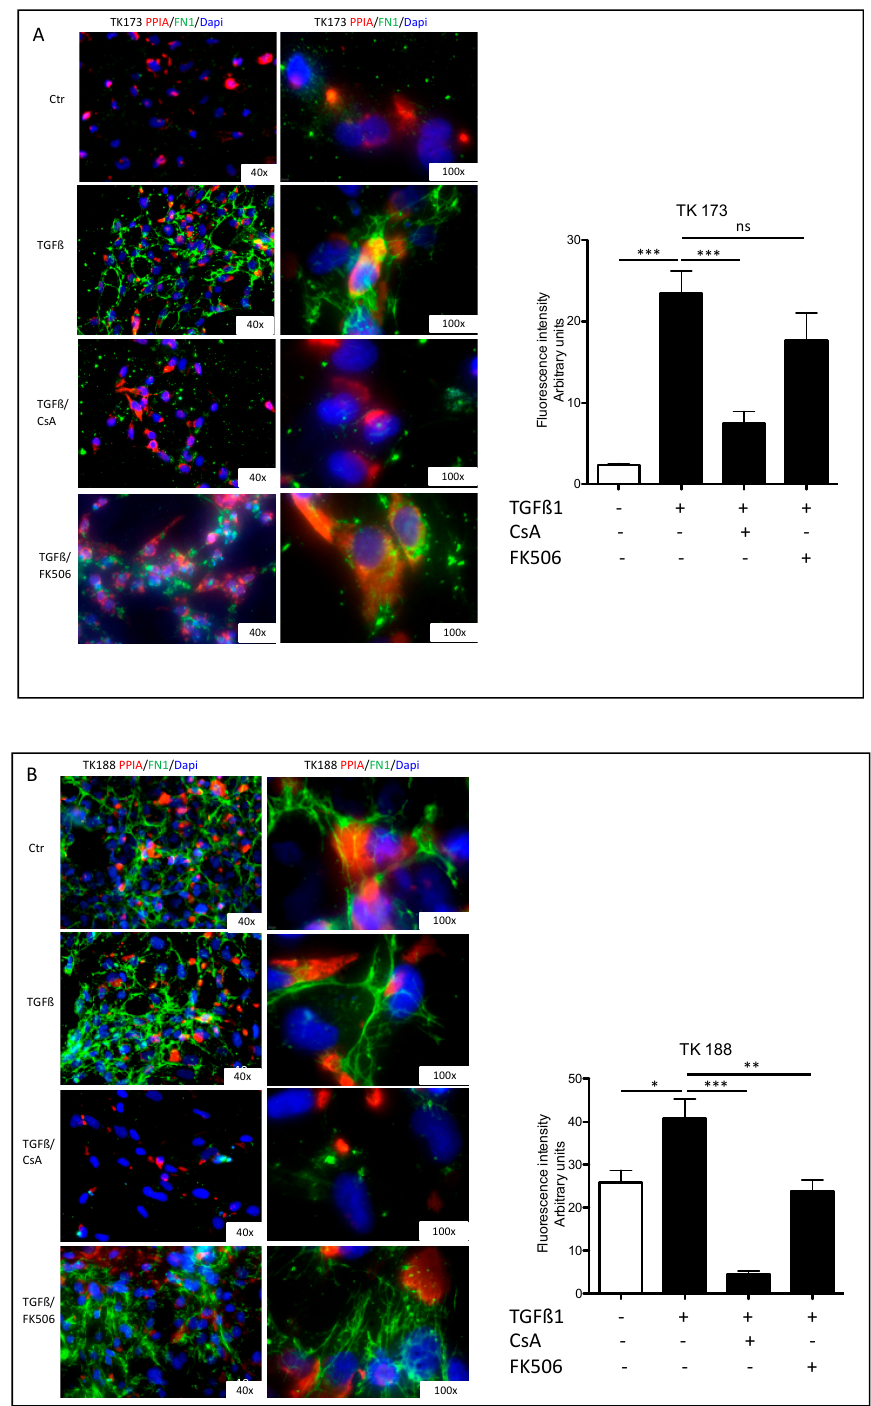
Figure 6. PPIA inhibition resulted in significant alteration in FN1 synthesis and accumulation. Renal fibroblasts cell lines were treated with TGF β 1 or TGF β 1 combined either with CsA or FK506 for 48 h. After the fixation with paraformaldehyde, the cells were stained with antibodies against PPIA and FN1. Fluorescence quantification (arbitrary units) is presented as a grouped bar chart with error bars. Significant di ff erences: * p < 0.05, ** p < 0.01, *** p < 0.001. ( A ) TK173 left panel 400 × magnification and right panel 1000 × magnification; ( B ) TK188 left panel 400 × magnification and right panel 1000 ×